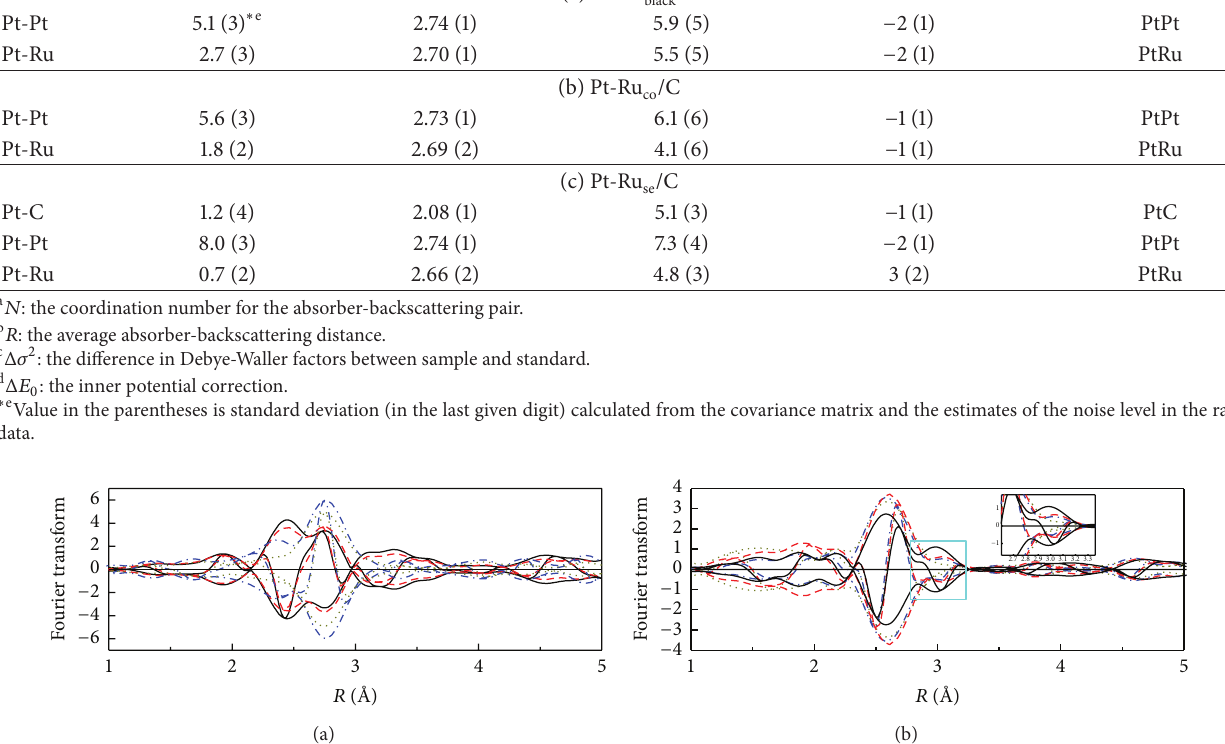
Figure 4: (a) Imaginary part and magnitude of Fourier transform ( 𝑘 2 -weighted, 3.0 < 𝑘 < 16 ˚A EXAFS data at Pt L III edge for Pt-Ru black (black line), Pt-Ru co /C (red line), Pt-Ru se /C (blue line), and Pt/C (dark yellow line). (b) Imaginary part and magnitude of Fourier transform ( 𝑘 2 -weighted, 3.0 < 𝑘 < 14 ˚A for Pt-Ru black (black line), Pt-Ru co /C (red line), Pt-Ru se /C (blue line), and Ru/C (dark yellow